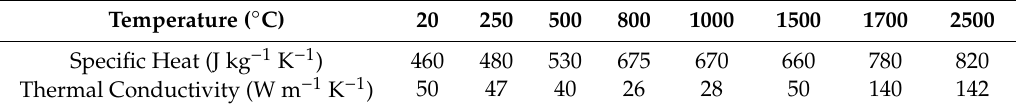
Table 4. Specific heat and thermal conductivity with elevated temperature.